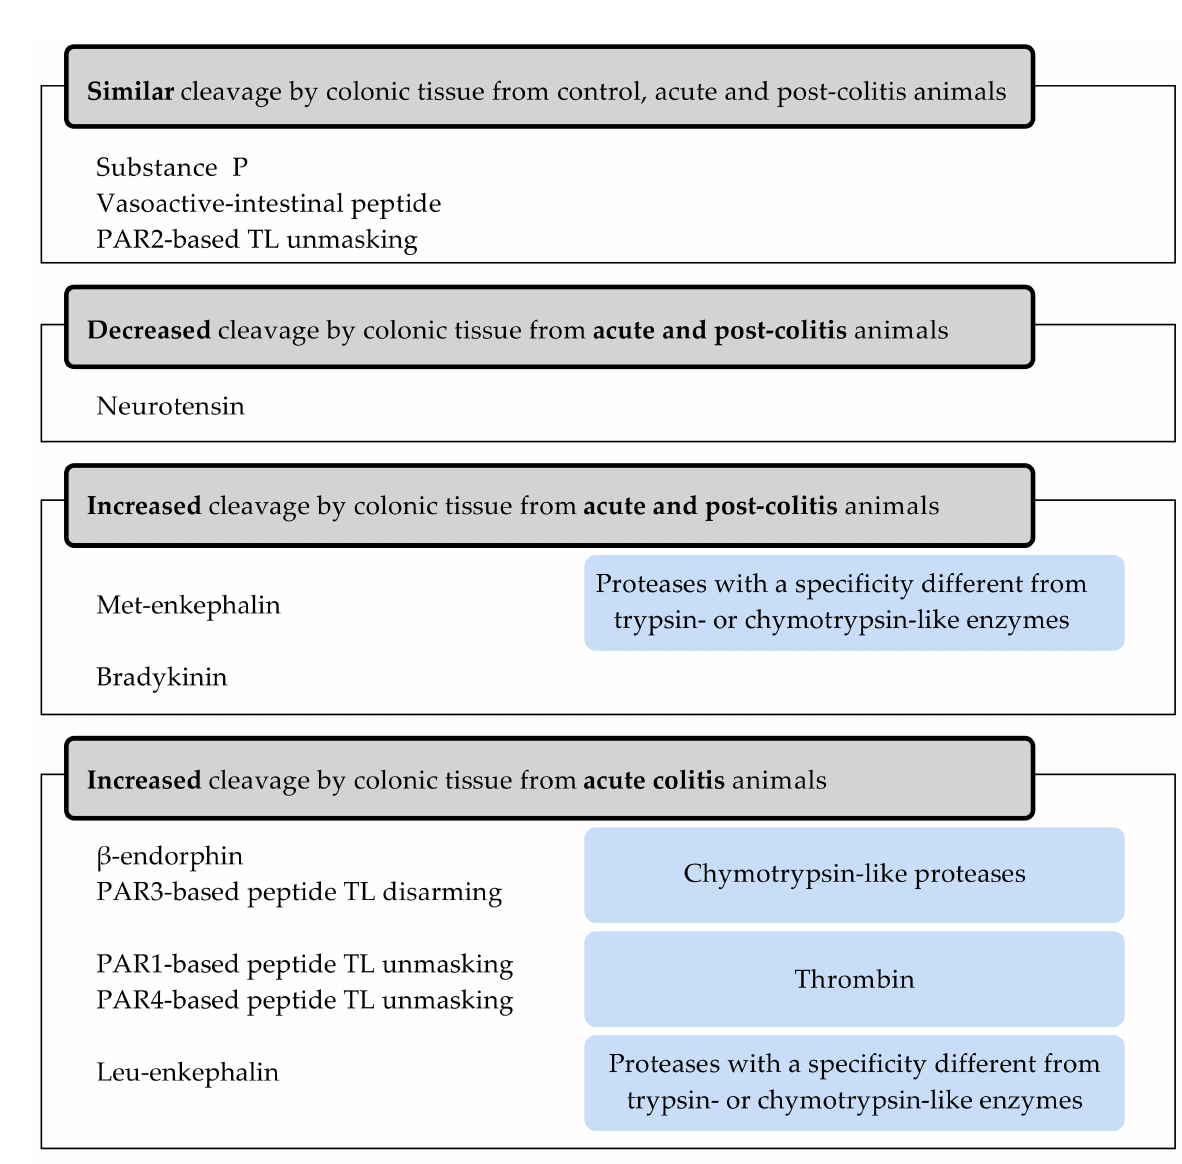
Figure 8. Summary of the effect of colonic tissue lysates from a TNBS-induced colitis model in the acute or post-inflammatory phase on the cleavage of bioactive peptides. The blue boxes show the hypotheses regarding proteases involved in acute or post-colitis resulting from the observed differences in peptide cleavage efficiencies by colonic tissue between the acute or post-colitis rat model and